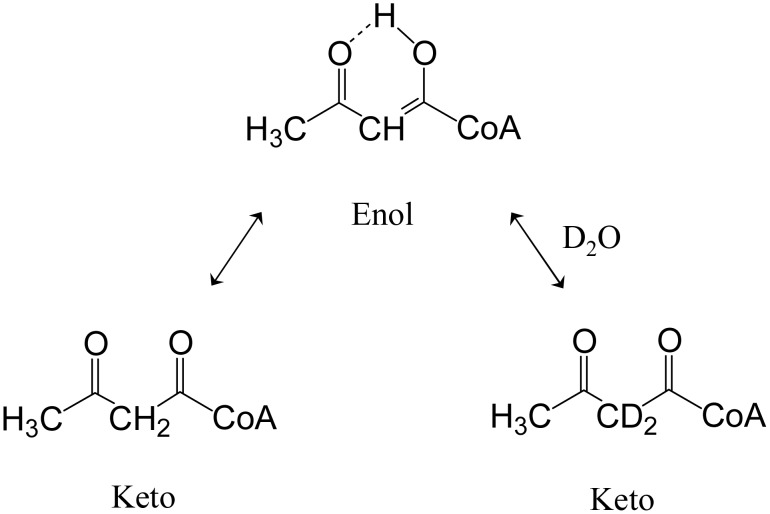
Tautomerization of acetoacetyl-CoA.Tautomerization allows H/2H-exchange at the C2-position of the 3-oxobutyryl-moiety of acac-CoA, and thus provides the precursor for the synthesis of [4-2H2]DPM.